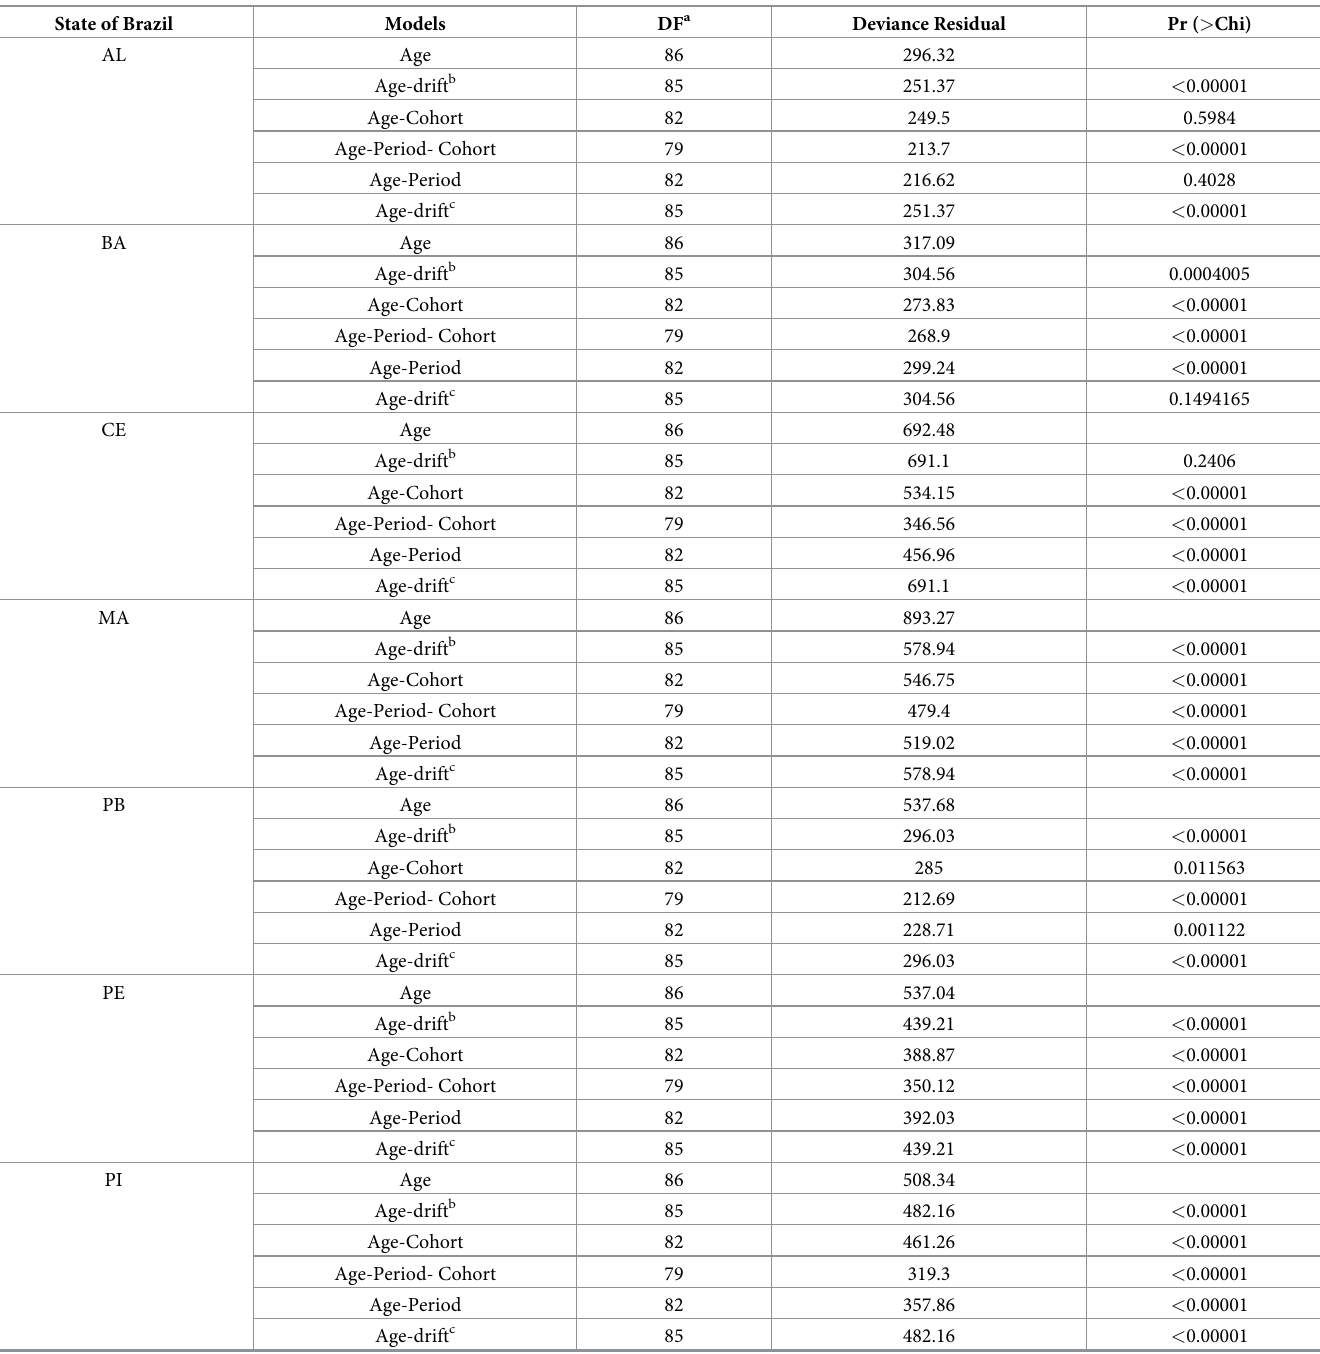
Table 2. Deviance analysis in sequential construction of APC